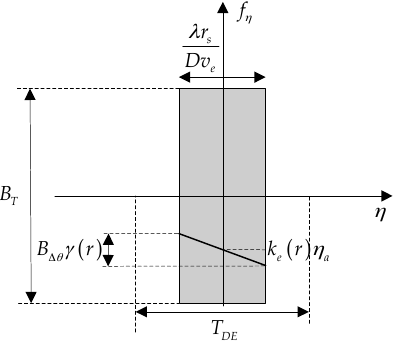
Figure 5. Azimuth time-frequency diagram after derotation.